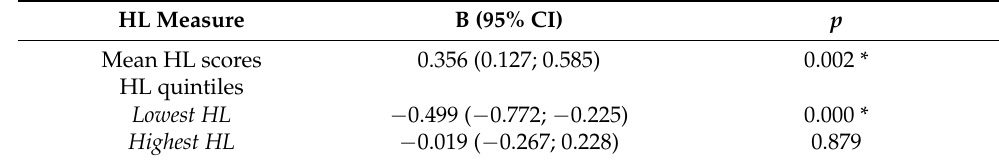
Table 3. Relationship between children’s HL and PA summary scores.